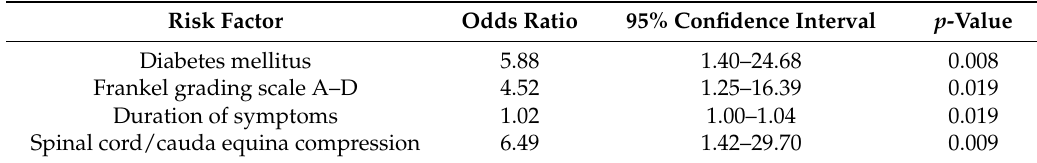
Table 3. Binary logistic regression of factors predicting an unfavourable outcome from